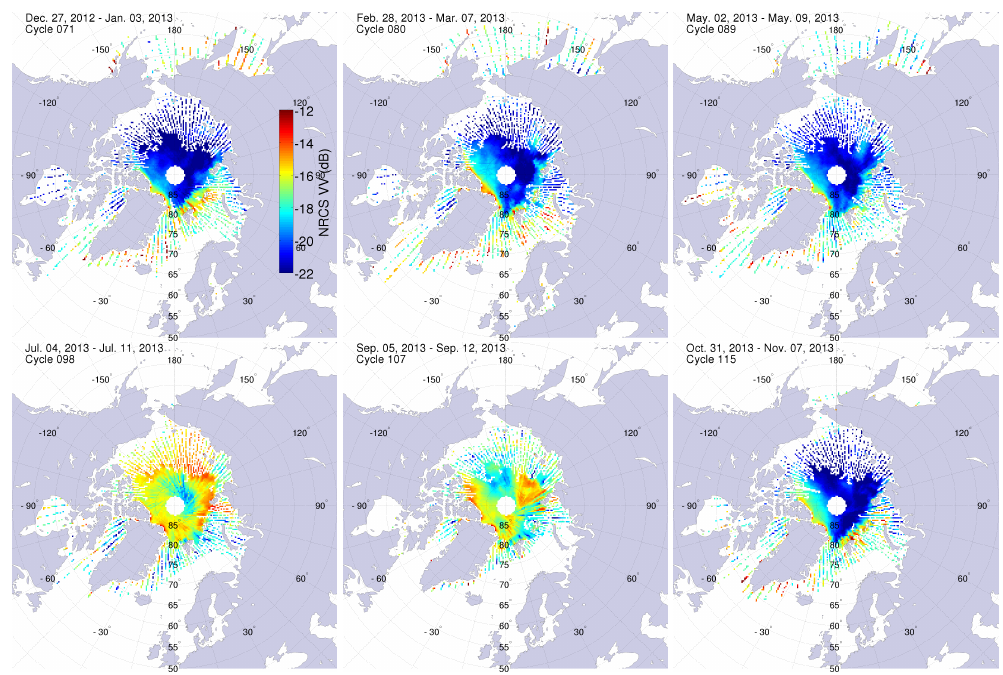
Fig. 14. Maps of beam 3 NRCS VV over the NH sea ice every two months in 2013. Grid cells where the land fraction was more than 0.25 were masked.